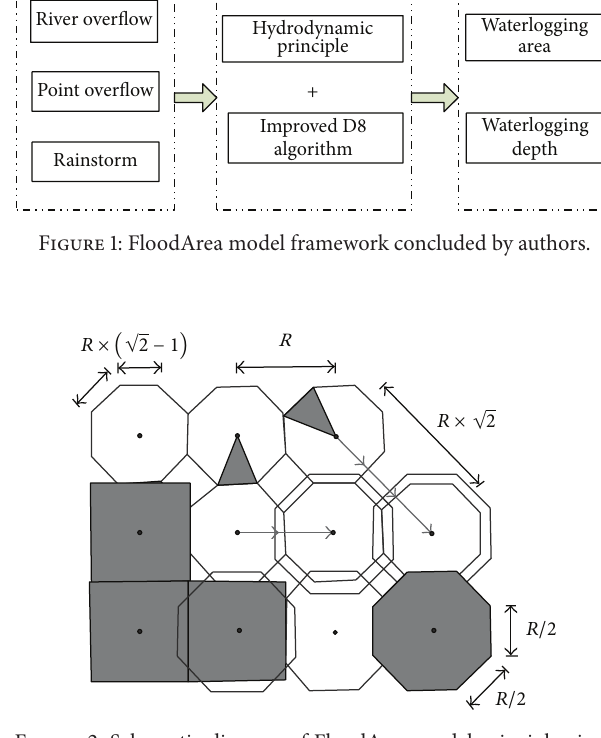
Figure 2: Schematic diagram of FloodArea model principle given by the FloodArea model user’s manual